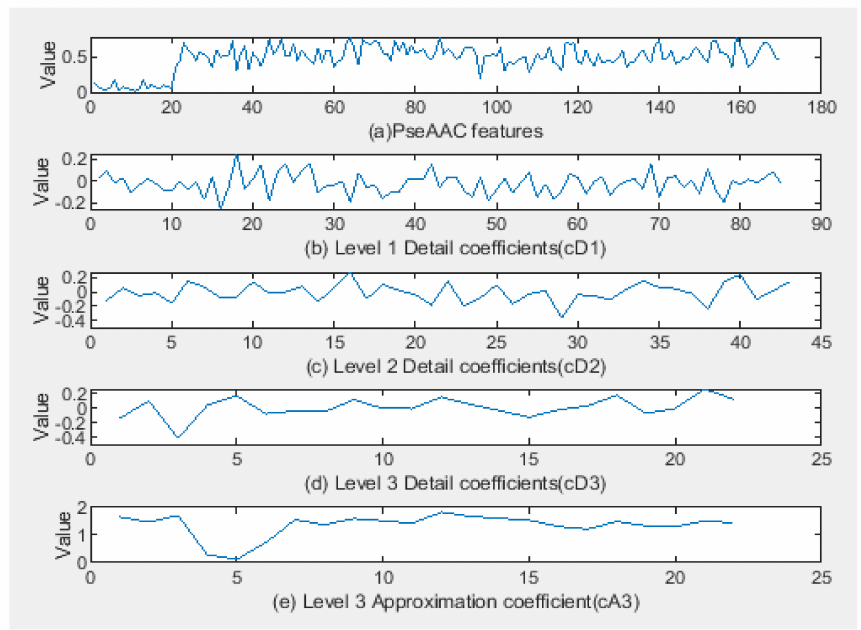
Figure 4. Representation of PseAAC features for class A GPCR proteins using the Coiflet 4 DWT wavelet family with 3 decomposition level.